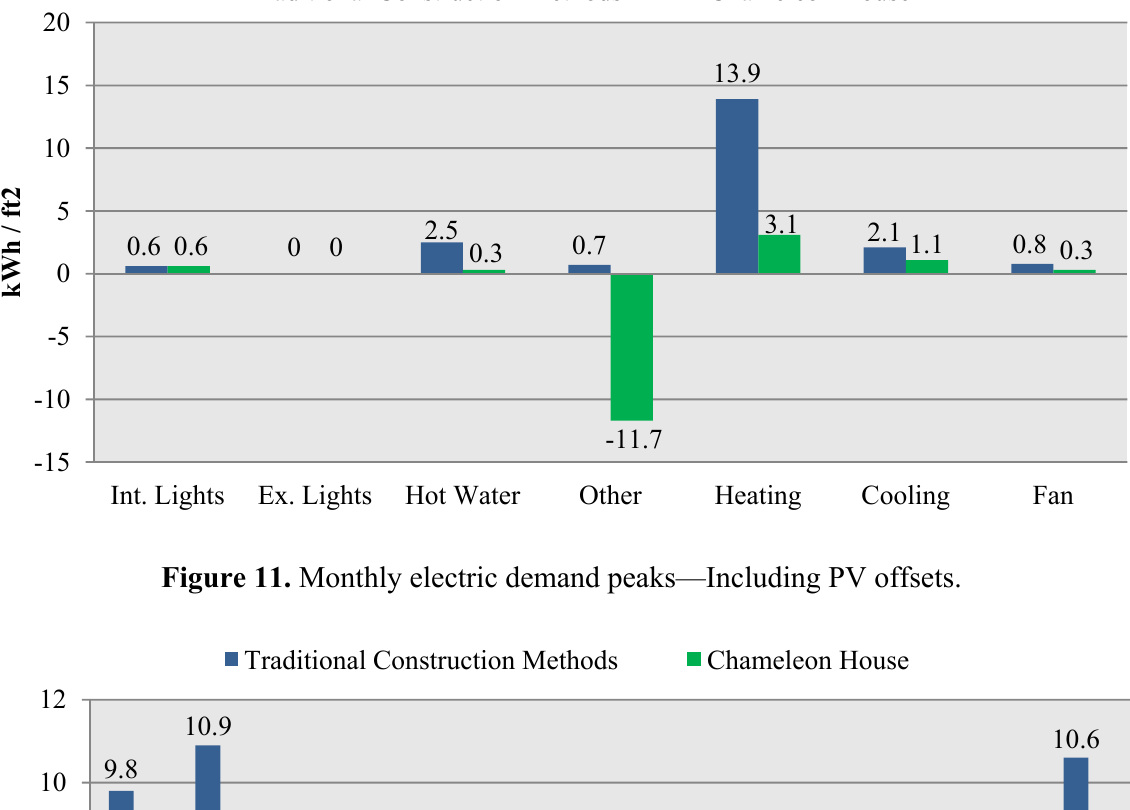
Figure 10. Annual electric use breakdown—Including PV offsets.